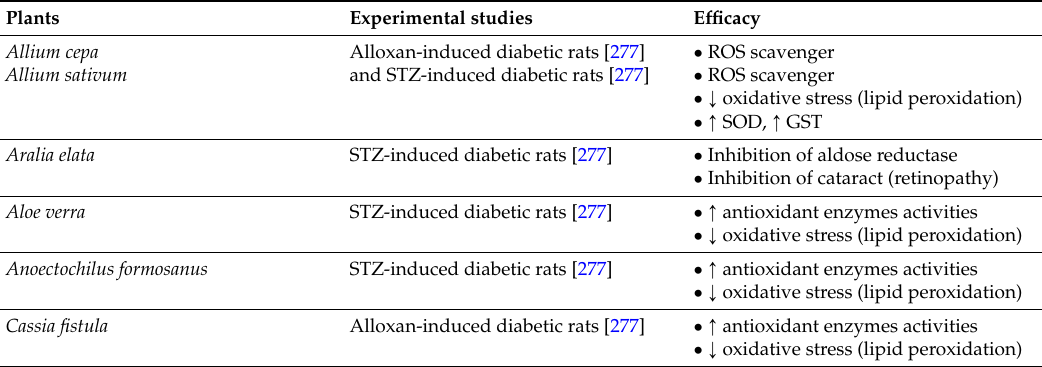
Table 2. Effects of plants on oxidative and metabolic